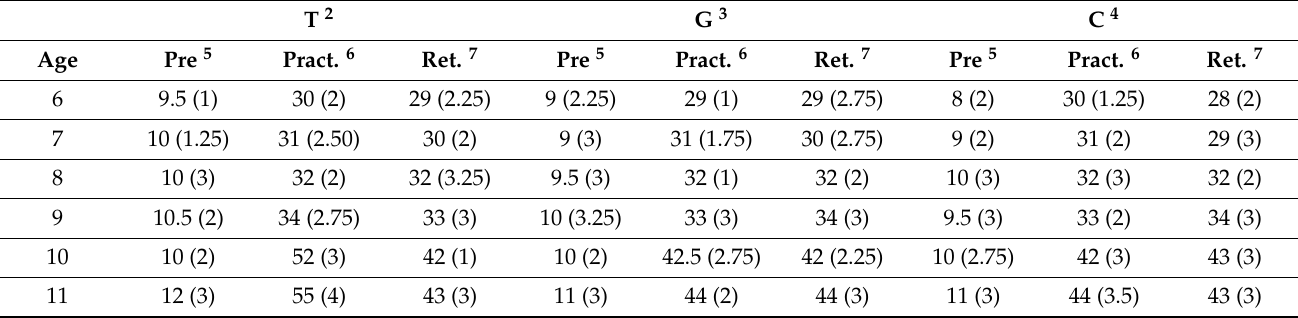
Table 6. PBT performance scores 1 per age, group, and experimental